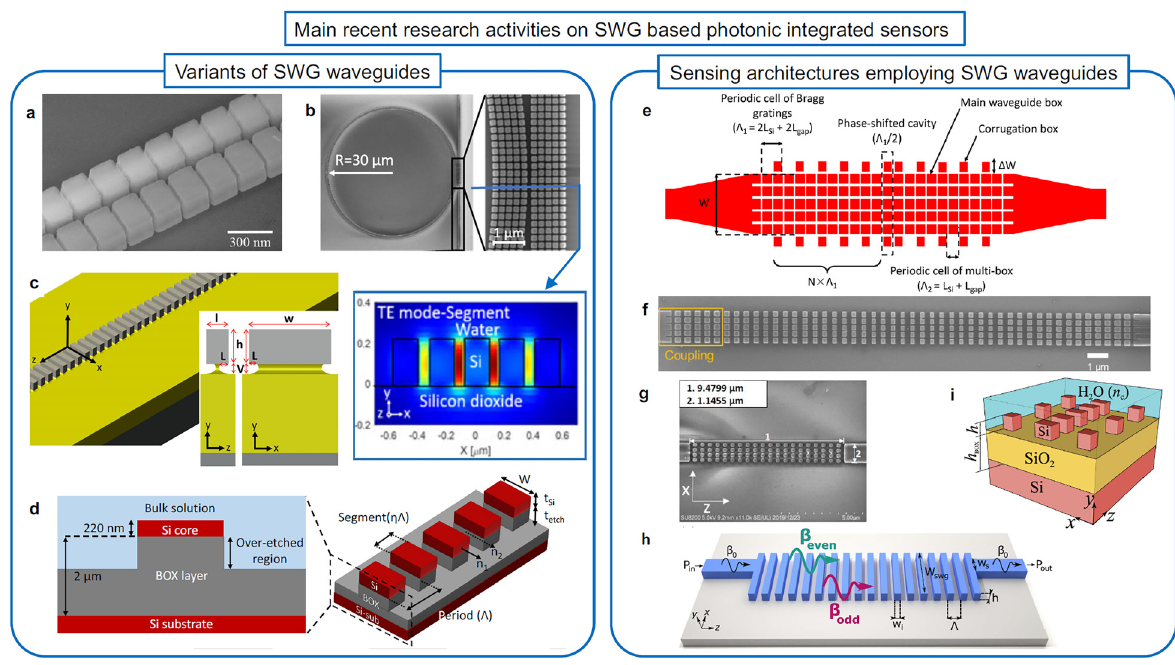
Figure 19: Summary of the most relevant recent works in SWG-based photonic integrated sensors. (a) SEM image of the slot SWG waveguide (reproduced with permission from Ref. [172]). (b) SEM image of the multibox SWG waveguide embeddedinaring-resonatorarchitecture. Theinsetshowsthetransverseelectric fi eldpro fi leat themiddleof thesiliconblocks(reproduced with permission from Ref. [173]). (c) Schematic of the pedestal SWG waveguide (reproduced with permission from Ref. [175]). (d) Schematic of theSWGwaveguidewithover-etchedsubstrate(reproducedwithpermissionfromRef.[176]).(e)SchematicofthemultiboxSWGphase-shifted Bragg grating resonator, in which the external Si blocks of period Λ 2 constitute the Bragg corrugation (reproduced with permission from Ref. [177]). (f) SEM image of the multislot photonic crystal cavity (reproduced with permission from Ref. [178]). (g) SEM image of the multislot SWG Bragg grating (reproduced with permission from Ref. [179]). (h) Schematic of the bimodal SWG interferometric sensor (reproduced with permission from Ref. [180]). (i) Schematic of the SWG-based Bragg fi lter topology used as a sensor (reproduced with permission from